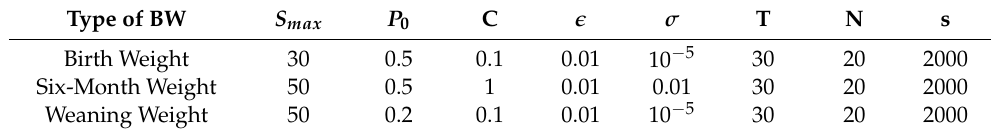
Table 2. The parameters values used in the proposed method for analyzing the body weights.